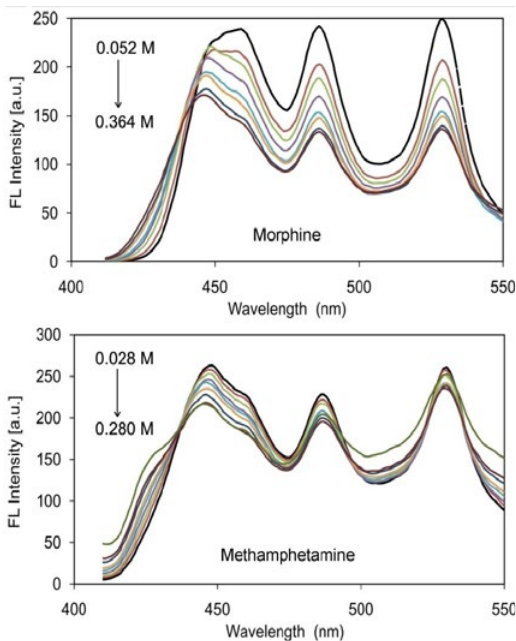
Fig. 8. The fluorescence spectra change of D-cyst-CdS-QDs upon addition of the various concentrations of